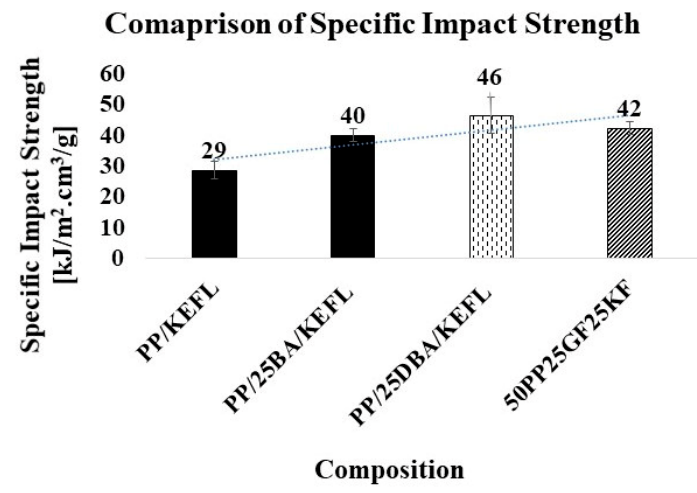
Figure 8. Comparison of impact energy absorption with bast/GF hybrid composite.